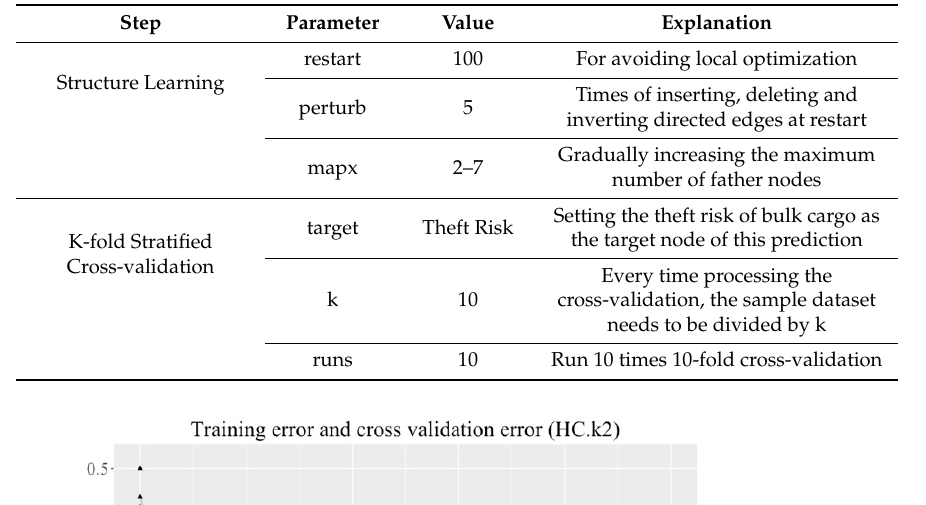
Table 5. Parameter setting in the methodology.